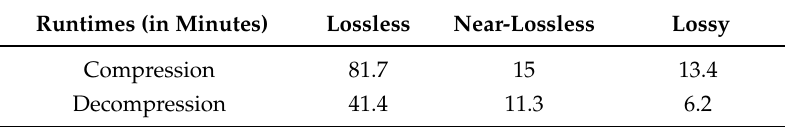
Table 10. Compression and decompression runtimes for the coding schemes that produce the best performance for lossless, near-lossless, and lossy compression. The PAE employed for near-lossless compression is 1. The target bit-rate used for lossy compression is 2 bpppc. All times are expressed in